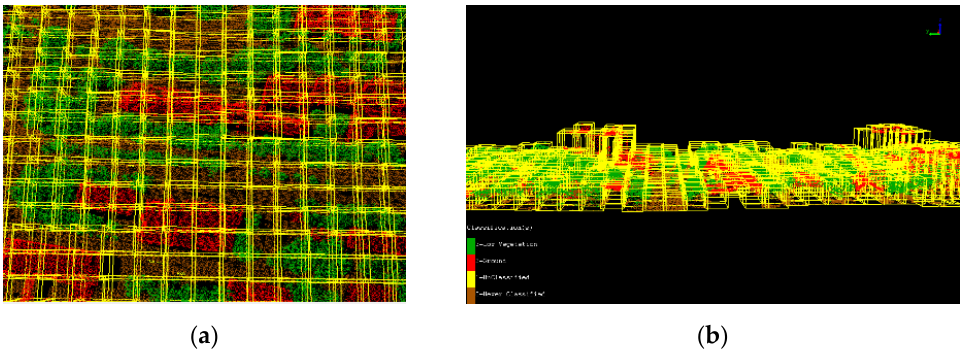
Figure 5. Construction of non-overlapping blocks measuring 15 m × 15 m for ALS point clouds: ( a ) Top view: ( b ) Side view.